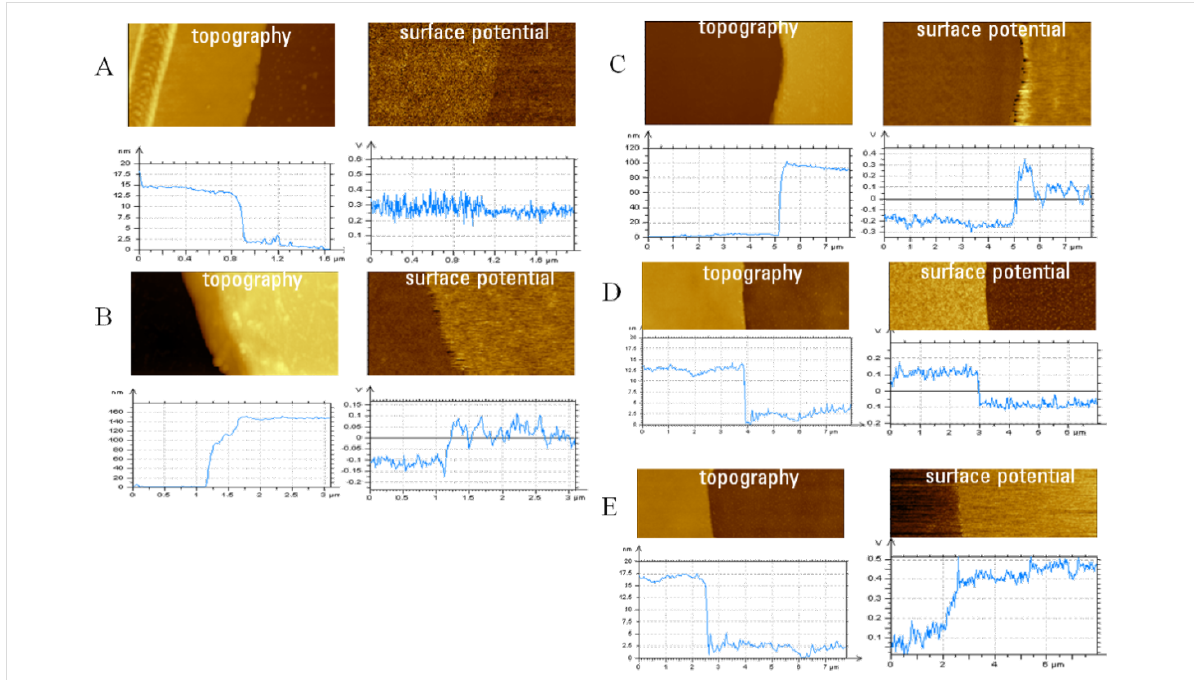
Figure 7: Topography and surface potential images, which were recorded at the scratch location in PS films of different thicknesses on a Si substrate, are presented in A and B. Similar images at the scratch location in PMMA films on Si are shown in C – E . The cross-section profiles, which were taken in the images, in the horizontal direction are shown under the images. The images in A – D were recorded with the sample in air and the image in E was recorded with the PMMA film in methanol